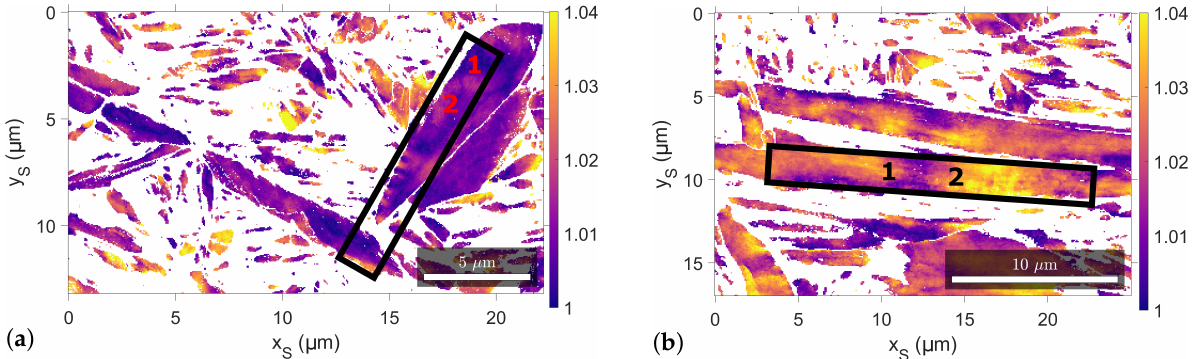
Figure 2. Local tetragonality c / a map determined by projective Kikuchi pattern matching [13,16] in EBSDwith a normalized cross-correlation coefficient r above 0.4. The white regions contain data points with an r value below 0.4 or are retained austenite. Lift-out regions ( a ) A and ( b ) D are marked by black rectangles, and the numbers 1 and 2 indicate the approximate positions of the APT tips, e.g., A1 or